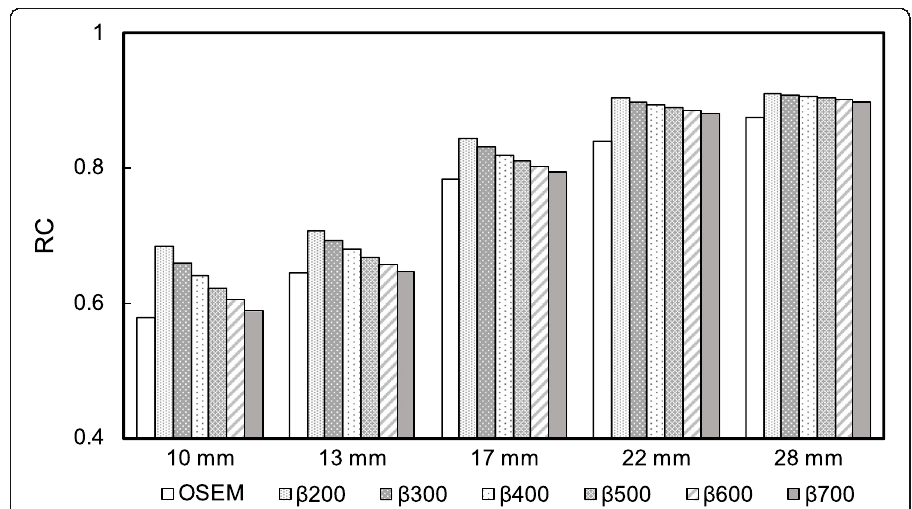
acquired over 120 s